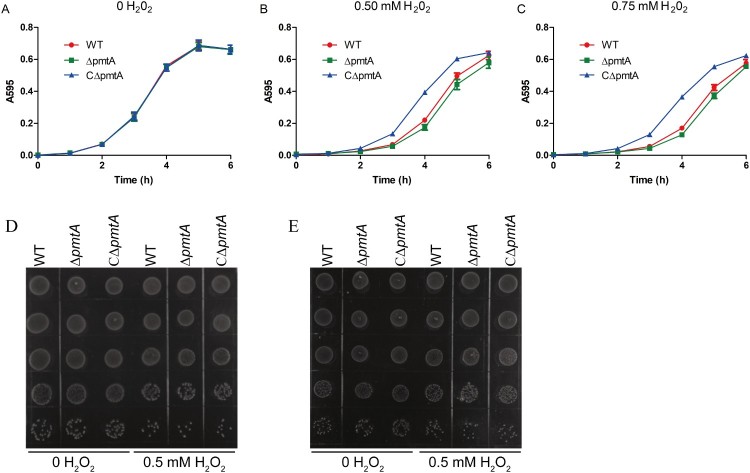
PmtA is involved in S. suis resistance to H2O2-induced oxidative stress. The S. suis strains were grown to exponential phase in the presence of 2 mM FeSO4. The cells were collected, diluted in fresh medium, and grown in the absence (A) and presence of 0.5 mM (B) or 0.75 mM H2O2 (C). Graphs data are mean values ± SD from three wells. (D–E) Spot dilution assays of the S. suis strains grown in the presence of 0.5 mM H2O2. At 4 h (D) and 6 h (E), aliquots were removed from the cultures, serially diluted 10-fold up to 10–5 dilution, and 5 μl of each dilution was spotted onto the plates from 10–1 (top) to 10–5 (bottom). The graphs are representative of three independent experiments.